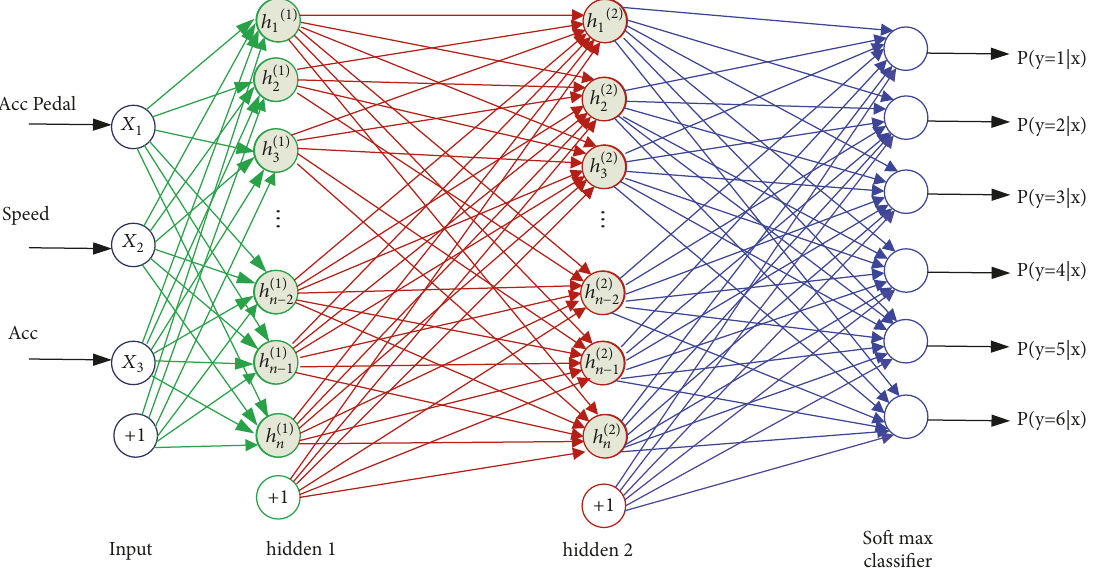
Figure 8: Neural network structure with three parameter inputs.